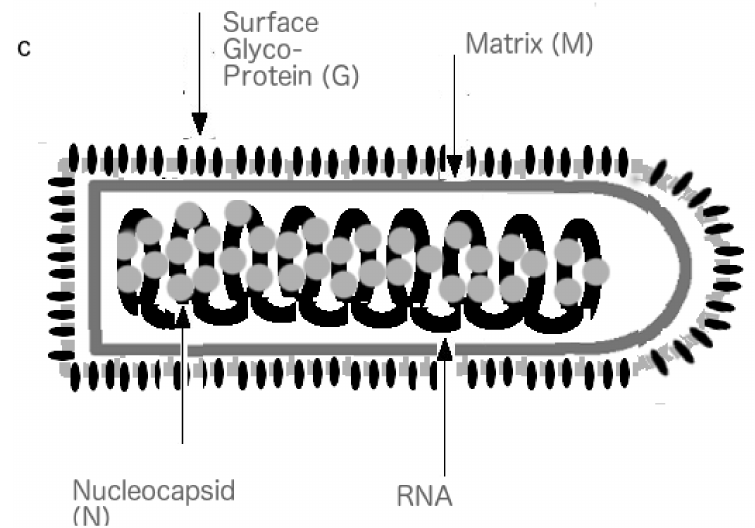
Figure 1. The shells of various viruses. ( a ) Virion of human immunodeficiency virus (HIV). ( b ) Rabies virus. ( c ) Variola (Smallpox) virus. (Figures reproduced with the permission of Gerard KM Goh,